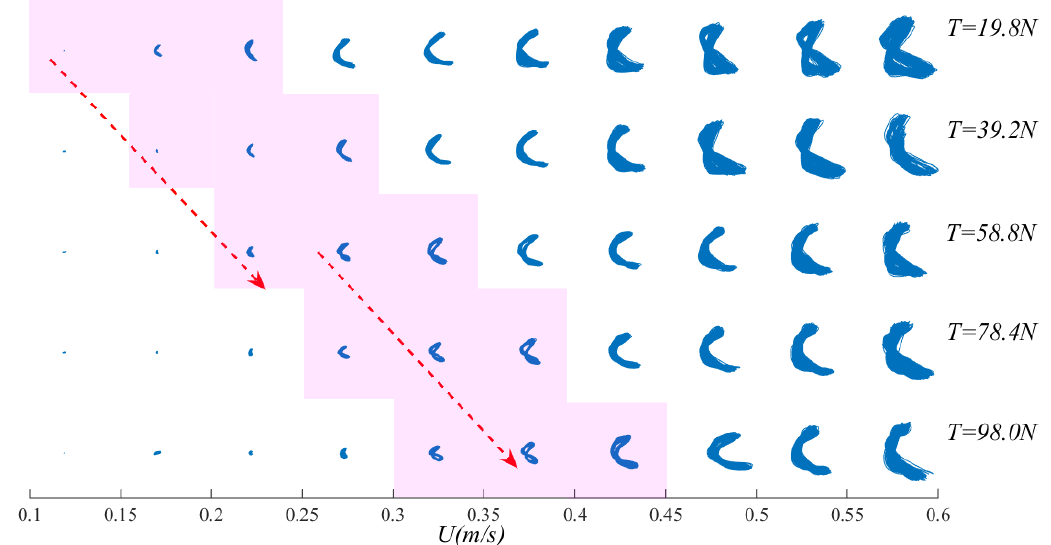
Figure 13. Riser vibration trajectories versus flow velocity under different top tensions.